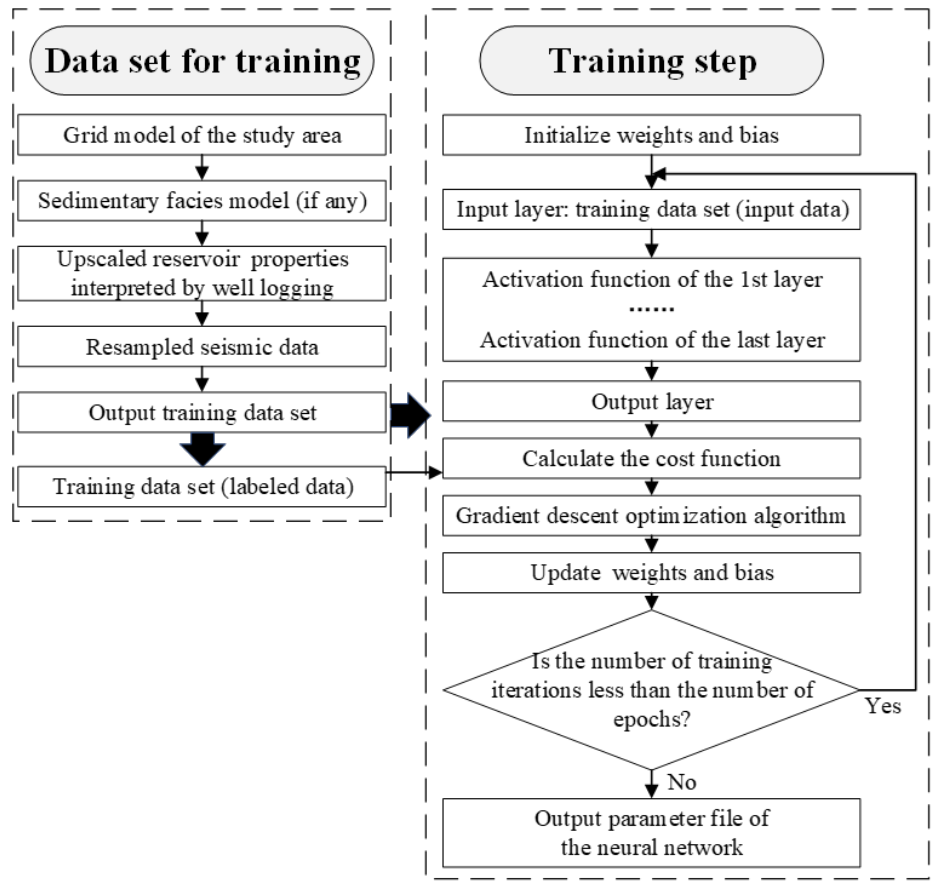
Figure 1. Flow chart of the deep feedforward neural network (DFNN) training process for 3D reservoir geological modeling.